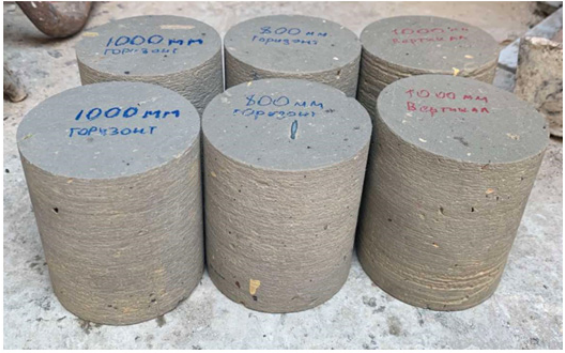
Figure 9. Selected samples of soil–cement (cores) (source: authors).